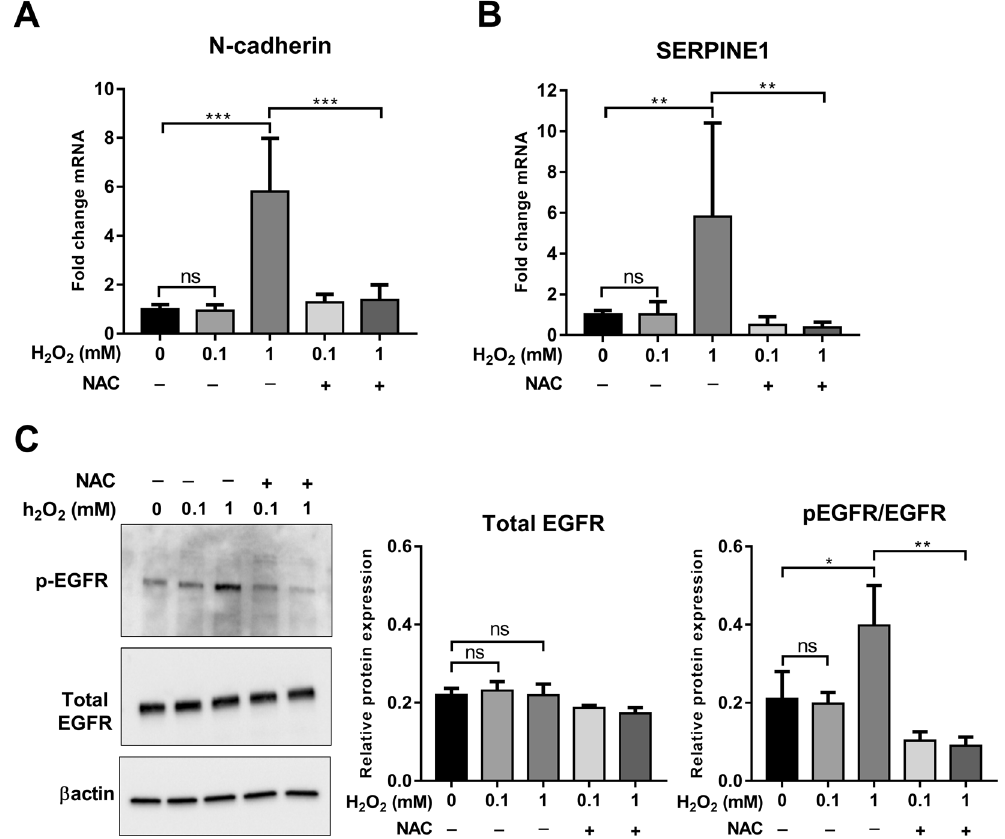
Figure 5. Effect of H 2 O 2 on the expression of N-cadherin and SERPINE1 and the phosphorylation of EGFR. Post serum reduction (24 h), MDA-MB-468 cells were treated with H 2 O 2 (0.1 and 1 mM) in the presence or absence of NAC (10 mM). The mRNA levels of N-cadherin ( A ) and SERPINE1 ( B ) were assessed using real time RT-PCR. ( C ) Representative cropped immunoblot (left) and densitometry analysis (right) of total EGFR (normalised to β -actin) and pEGFR (normalised to β -actin and total EGFR) (full-lenght immunoblots are shown in the Supplementary Fig. S2). ns = not significant ( p > 0.05), * p < 0.05, ** p < 0.01, *** p < 0.001 (one-